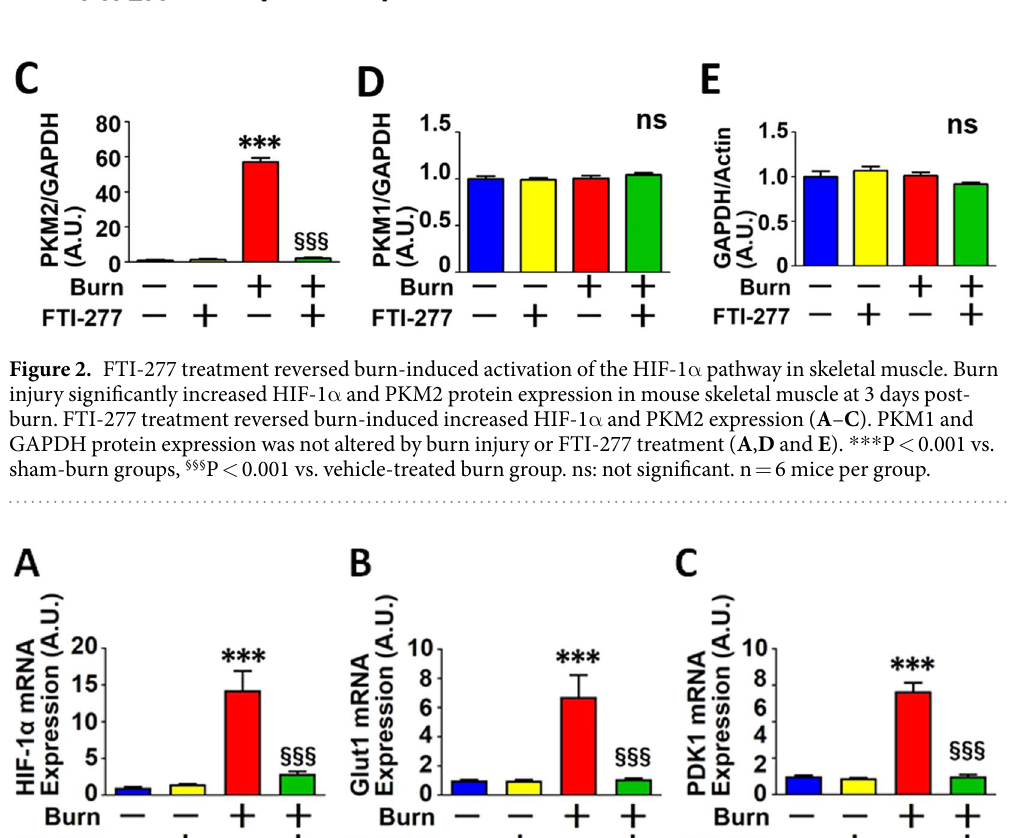
uncoupler (Fig. 5A, B and C). FTI-277 significantly ameliorated burn-induced decreases in ADP-stimulated and FCCP-stimulated OCRs (Fig. 5A, B and C). Next, we evaluated complex I-, complex II-, and complex IV-dependent electron transfer capacity by meas- uring rotenone-inhibitable, succinate-stimulated, and ascorbate-plus-TMPD-stimulated OCRs, respectively. Burn injury markedly suppressed complex I-, complex II-, and complex IV-dependent OCRs in mouse skeletal muscle compared with sham-burn. FTI-277 significantly ameliorated the burn-induced decreases in the OCRs (Fig. 5D, E, F and G). These data indicate that burn injury induced a general decrease in OCRs of various com- ponents of the electron transport chain to a comparable degree. FTI-277 did not alter mitochondrial function in sham-burned mice. Together, these results indicate that FTI-277 mitigated burn-induced suppression of mito- chondrial oxidative phosphorylation. FTI-277 prevented burn-induced morphological alterations of the mitochondria. Next, we stud- ied the effects of burn injury and FTI-277 on the morphology of the mitochondria in mouse skeletal muscle at 3 days after burn injury. Transmission electron microscopy revealed that burn injury resulted in morphological alterations of the mitochondria compared with sham-burn (Fig. 6C and G). Specifically, enlarged mitochondria